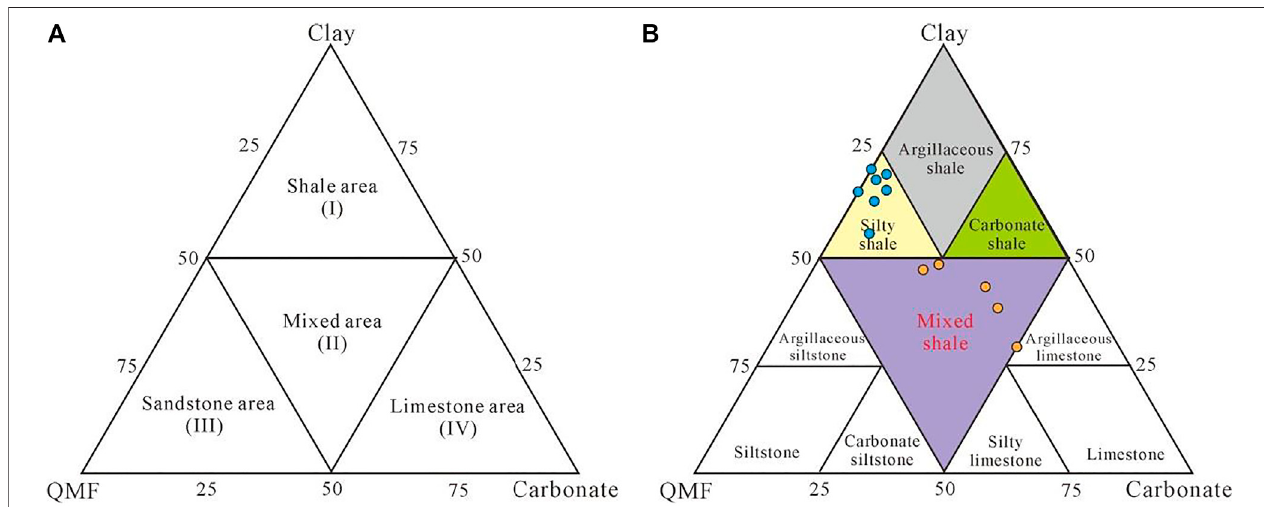
FIGURE 2 | Lithofacies of the Dongyuemiao shale in the Fuling area according to the ternary diagram; QMF: quartz, mica, and feldspar. (A) fi rst-level division of lithofacies; (B) secondary division of lithofacies.